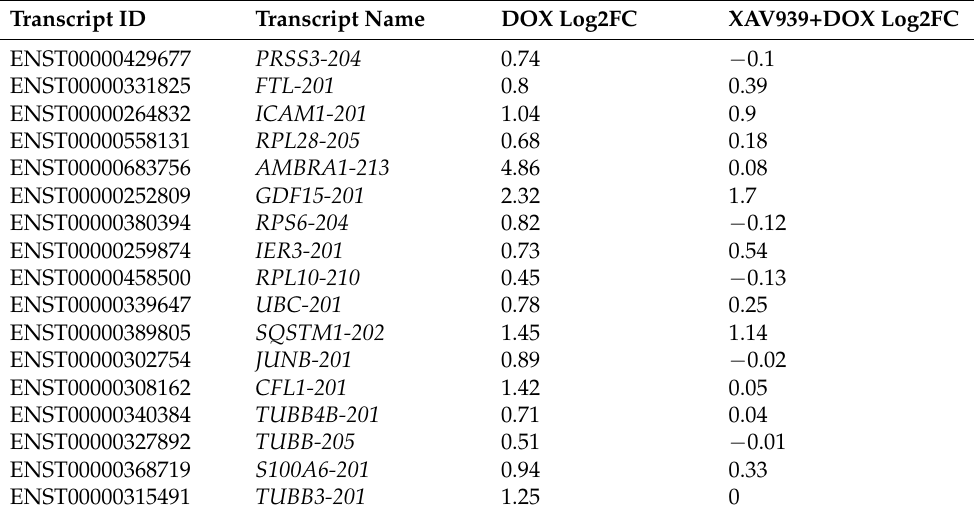
Table 8. Differential expression of transcripts potentially associated with the development of resis- tance to docetaxel treatment when PC3 cells are treated with XAV939+Docetaxel combination.